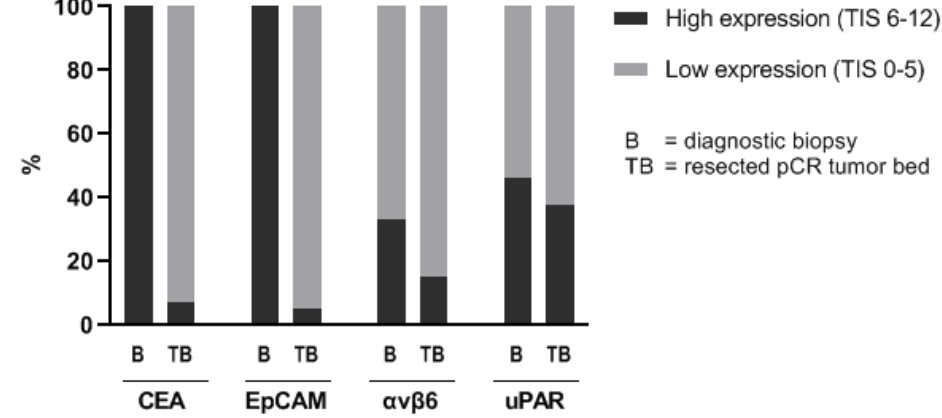
Figure 3. High and low expression in the diagnostic biopsy and resected pCR tumor bed. Notes: